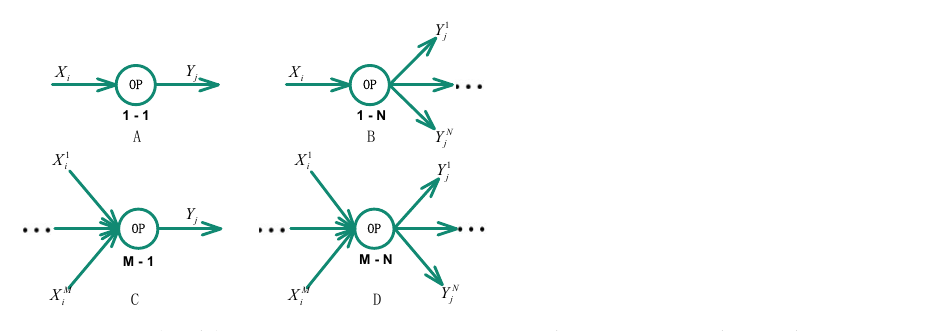
Figure 7. OP (circle) represents one DSP operator with X as its input data and Y as its output data. From left to right: ( top ) one input data with one output, one input with multiple outputs. ( bottom ) multiple input data with one output, multiple input data with multiple output